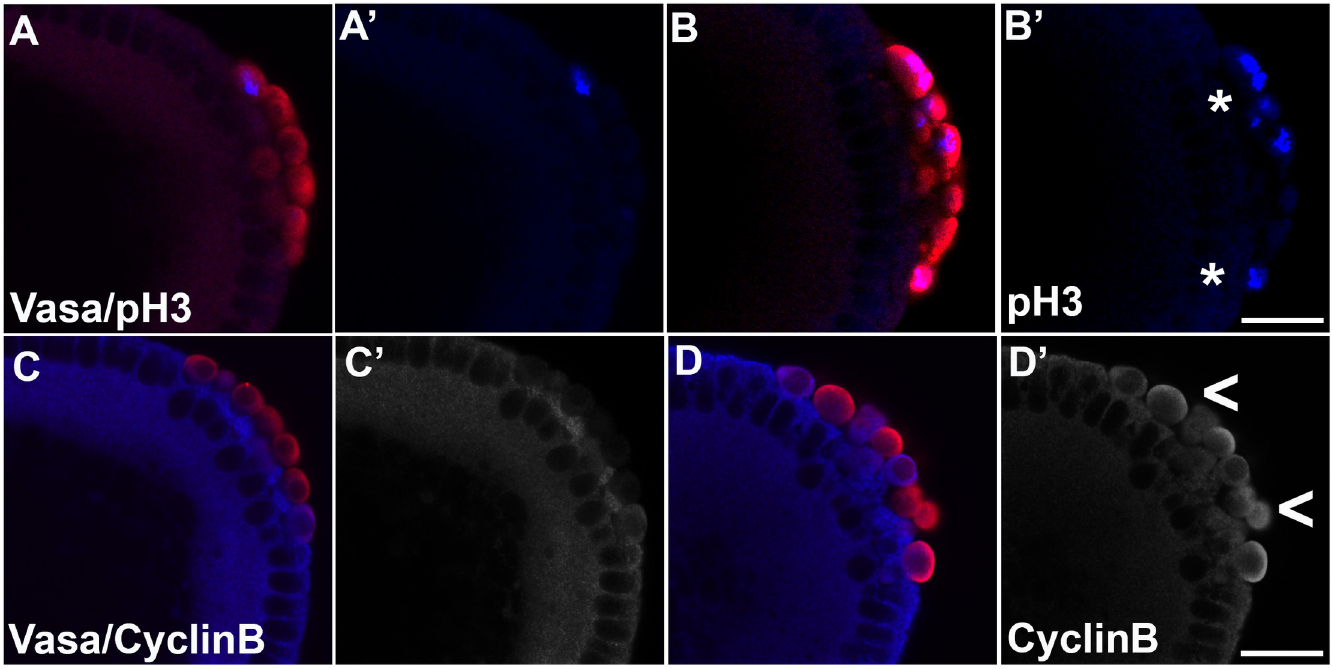
Fig 1. Ectopic expression of dpp using twist-Gal4 enhances mitosis, resulting in a modest increase in PGC count. (A/C) twi-Gal4 (B/D) or twi-Gal4/UAS-dpp embryos were stained for PGC marker Vasa (A-D, red) and either pH3 (A’-B’) or Cyclin B (C’-D’) (blue) to evaluate mitotic state of pole cells. Excess mitotic marker compared to WT levels in PGCs is indicated by asterisks (pH3) or carets (Cyclin B). Scale bar represents 10 μ m.